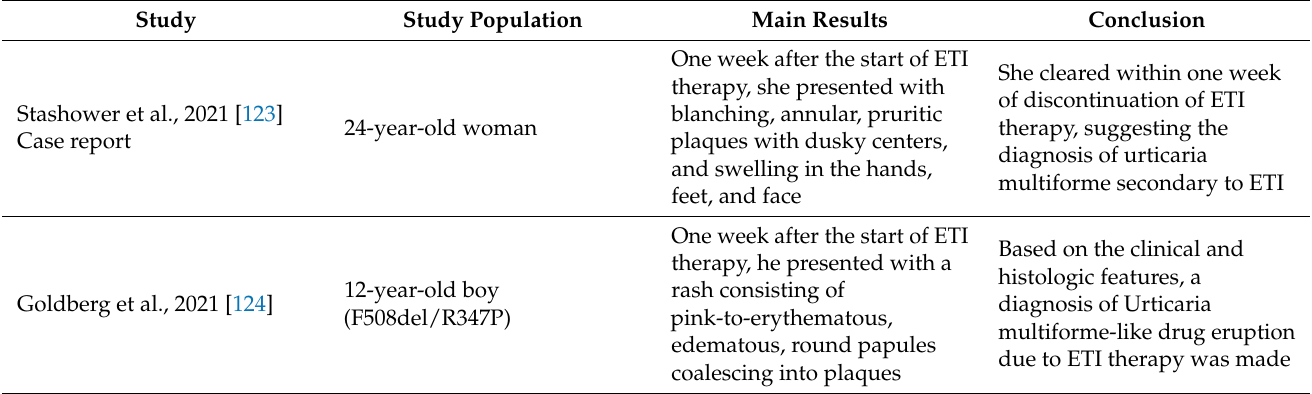
Table 8. Clinical studies assessing the effects of ETI therapy on skin symptoms and signs in